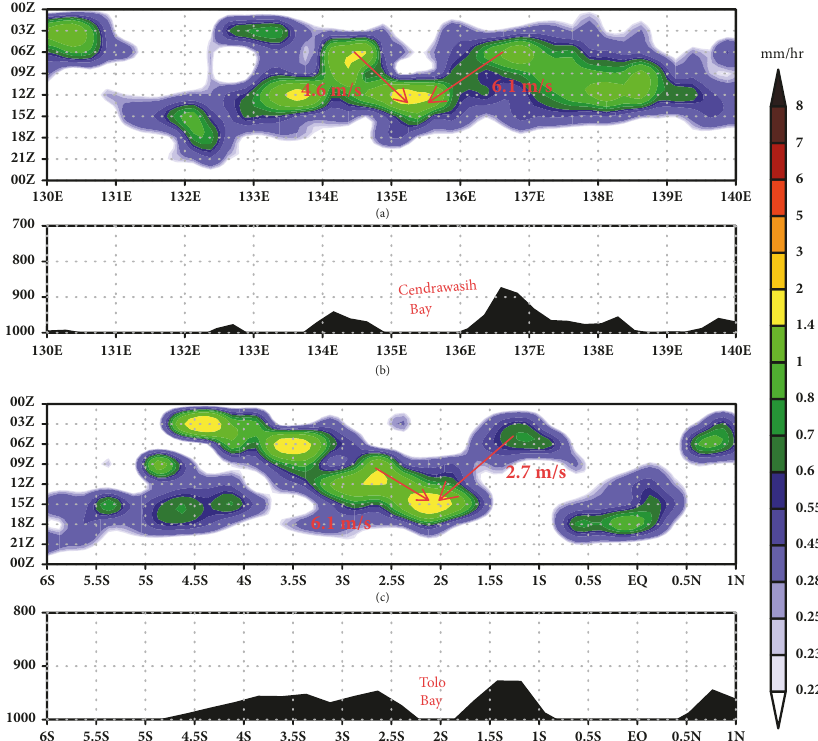
Figure 6: Hovmoller diagram shows propagation of rainfall over (a) Cenderawasih Bay and (c) Tolo Bay. (b) is the terrain height around Cenderawasih Bay based on cross section in Figure 2 (white line). (d) Terrain height around Tolo Bay based on cross section in Figure 2 (red